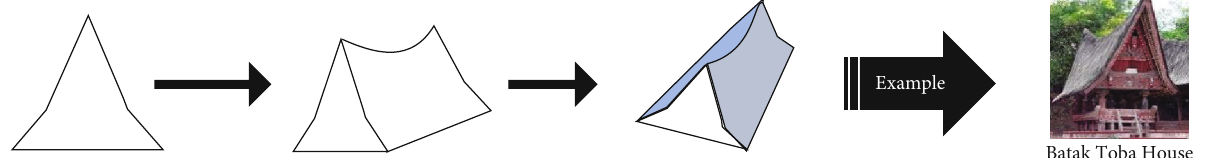
Figure 31: House diagrams of simple house III.